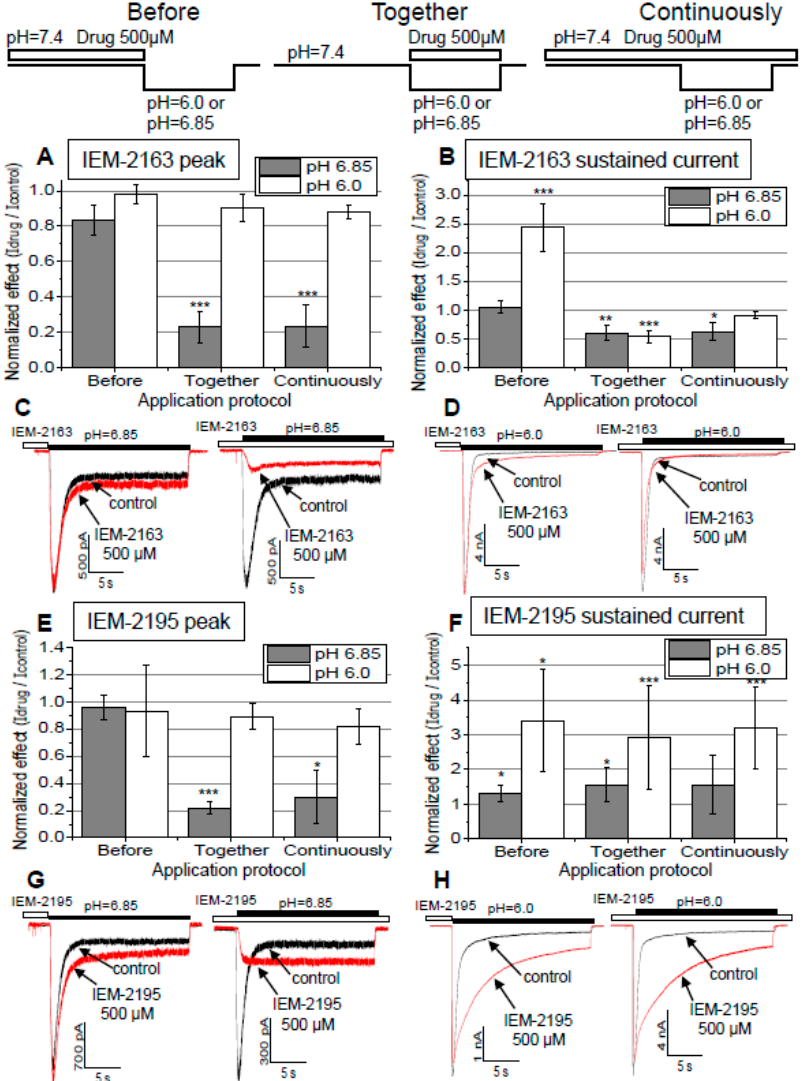
Figure 4. Effects of drug application protocol on peak and sustained currents of ASIC3 in different activating pH. Number of * denotes statistical significance at * p < 0.05, ** p < 0.01, or *** p < 0.001, respectively, n ≥ 5. ( A ) Effects of IEM-2163 on peak current and ( B) sustained